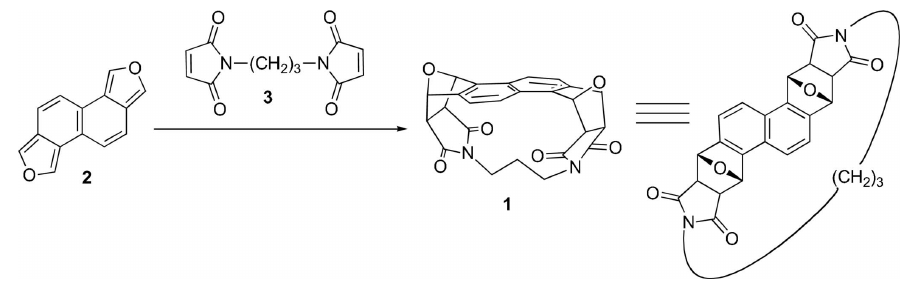
ORTEP - 3 (Farrugia, 1997) drawing of the title compound with displacement ellipsoids plotted at 50% probability level.